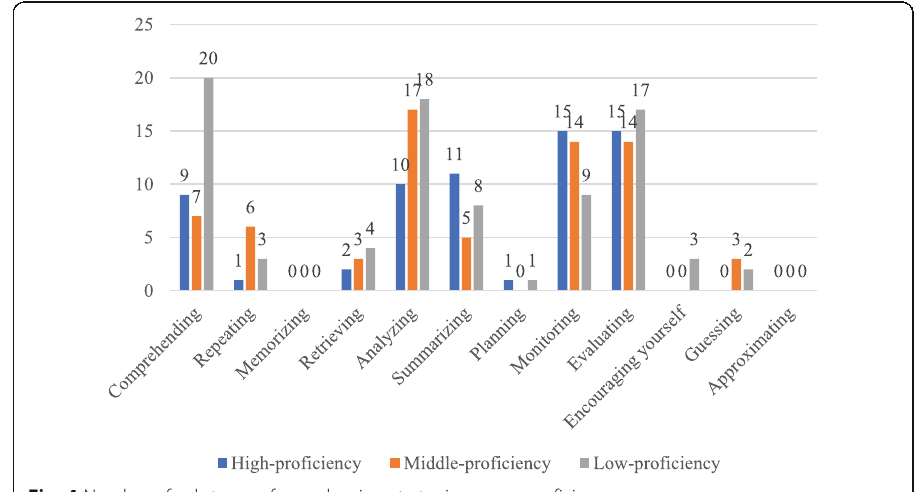
Fig. 4 Number of sub-types of paraphrasing strategies across proficiency